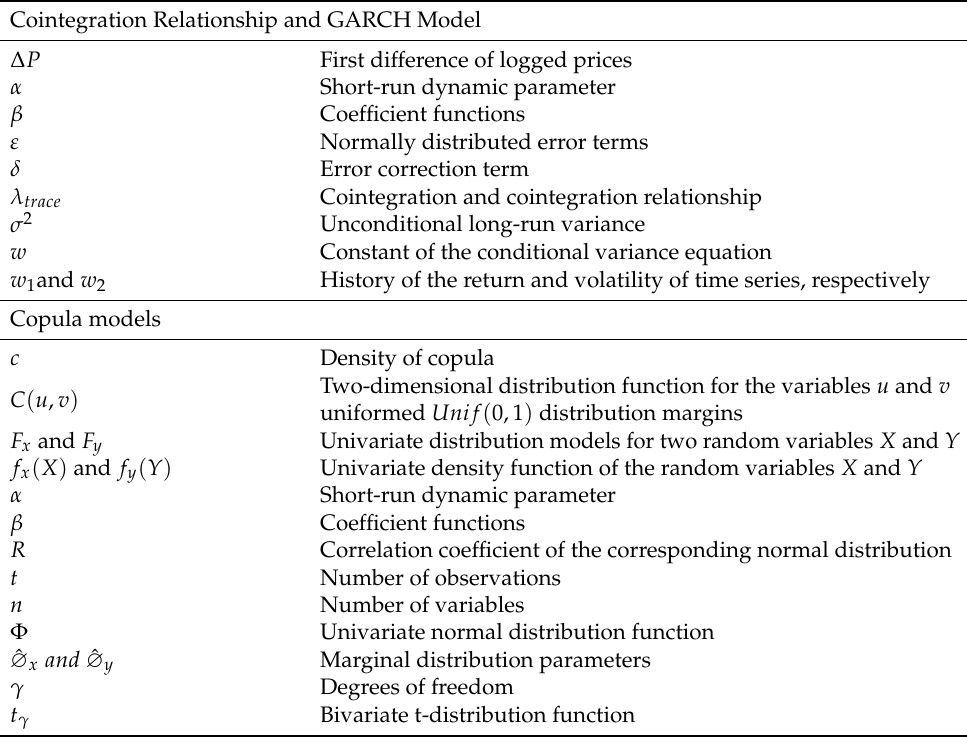
Table 1. Nomenclature table describing the model parameters and